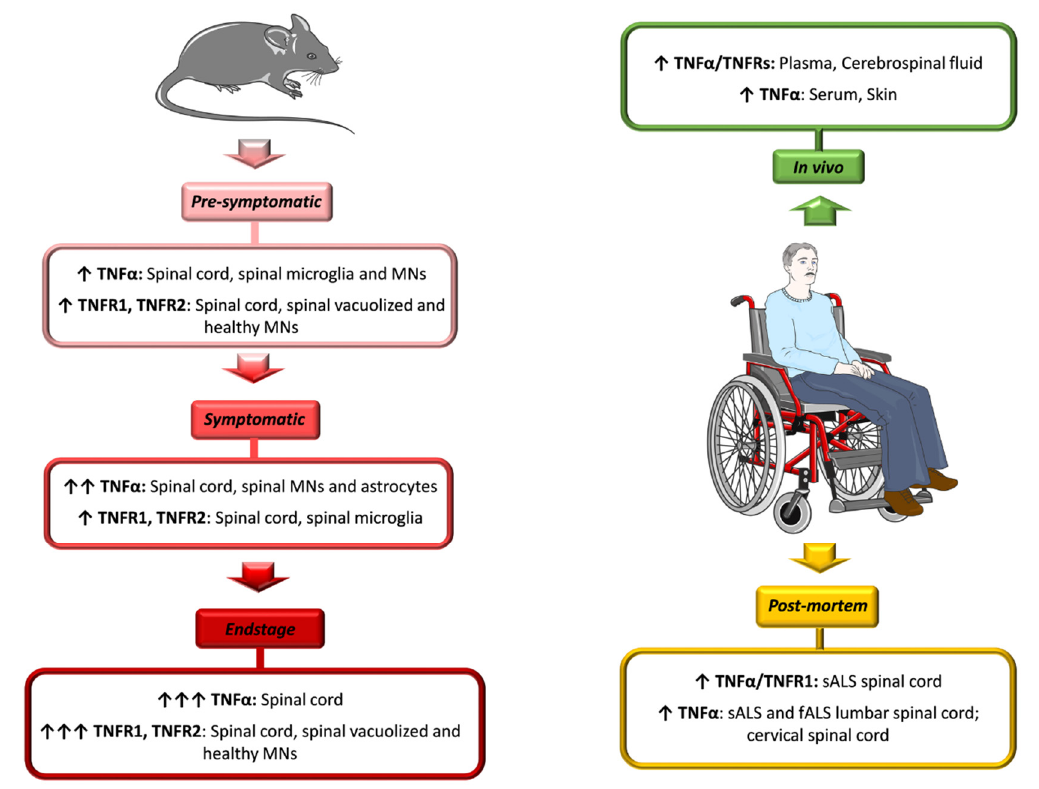
Figure 1. Schematic representation of the levels of TNF α and its receptors during amyotrophic lateral sclerosis (ALS) progression. Since the existence of a neuroinflammatory process is well known in neurodegenerative diseases, including ALS, numerous investigations have focused on studying the trend of concentrations of the pro-inflammatory cytokine TNF α and its receptors in ALS transgenic mouse models ( ↑ indicates increases in TNF α , TNFR1 or TNFR2 concentrations in the indicated tissues/cells), identifying a linear relationship between TNF α levels and stage of disease progression. Further observations were also made on living and post-mortem patients.